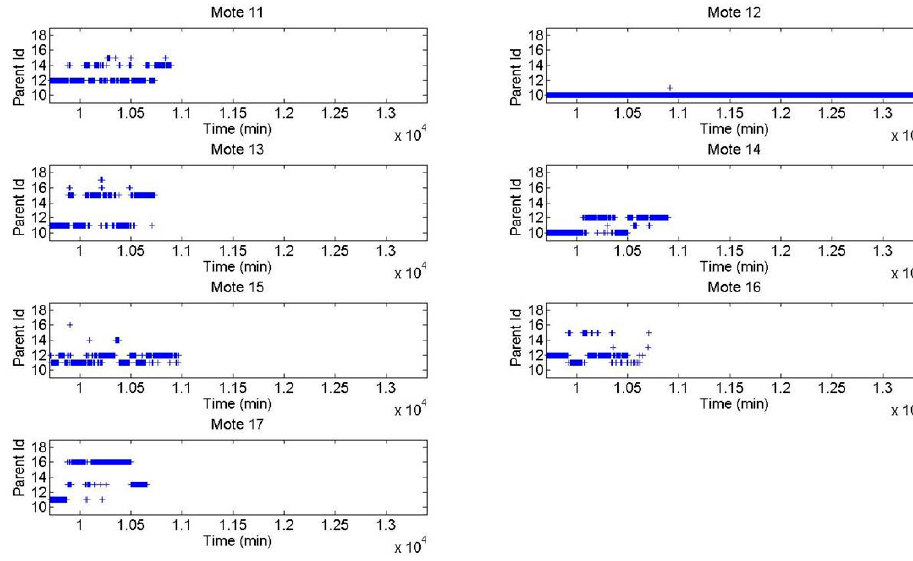
Figure 12. Parent identifiers of each message using the XMESH protocol during the last period of the WSN lifetime in Experiment 1.